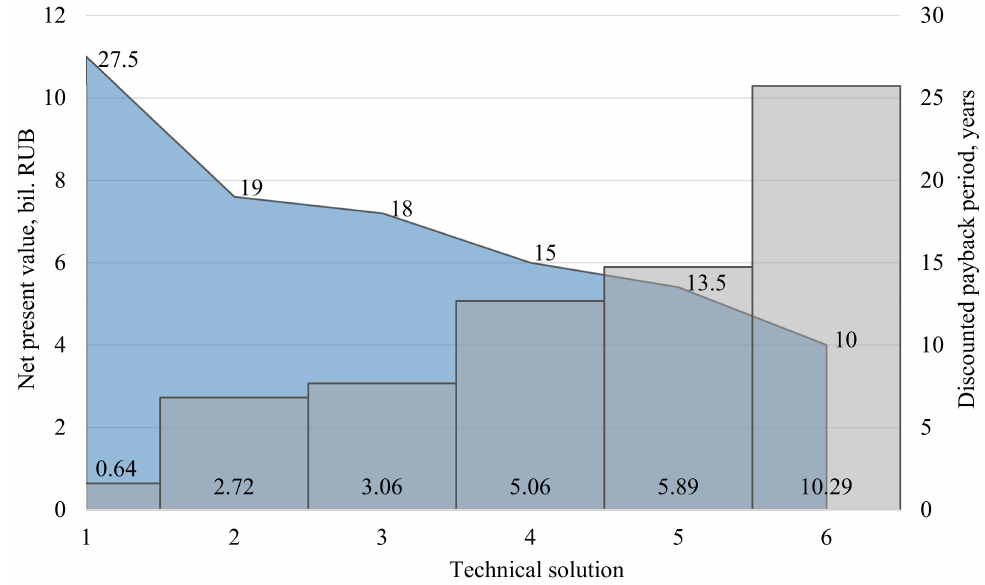
Figure 13. Financial performance of projects for high-temperature facilities